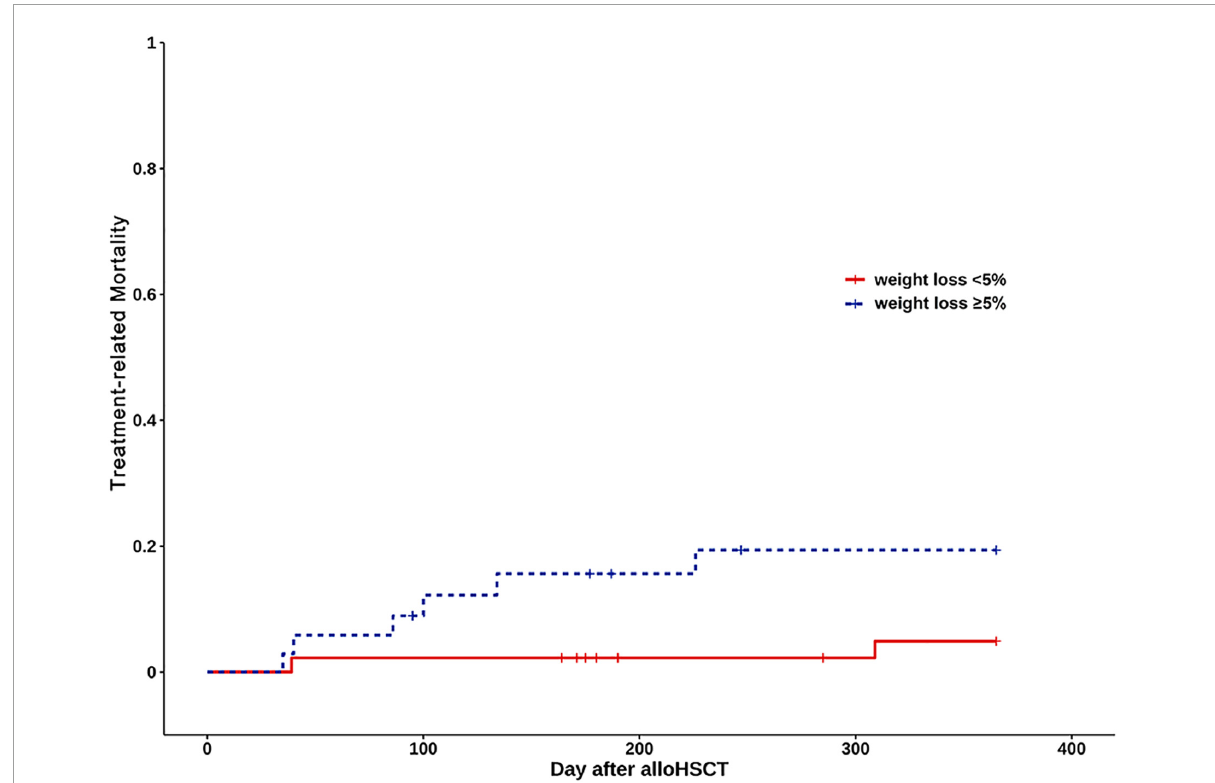
FIGURE3 Kaplan Meier curves of treatment-related mortality (TRM) for weight loss < 5% group (continuous line) and weight loss ≥ 5% (dashed line).